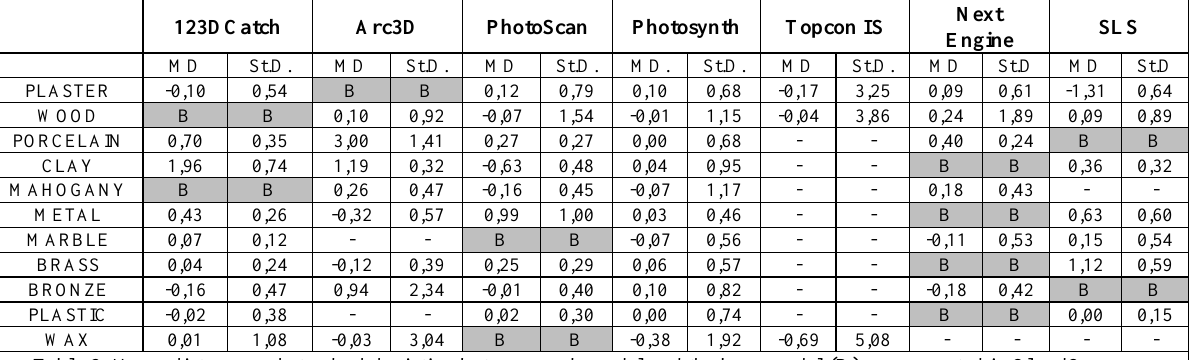
Table 2: Mean distance and standard deviation between each model and the base model (B), as computed in CloudCompare